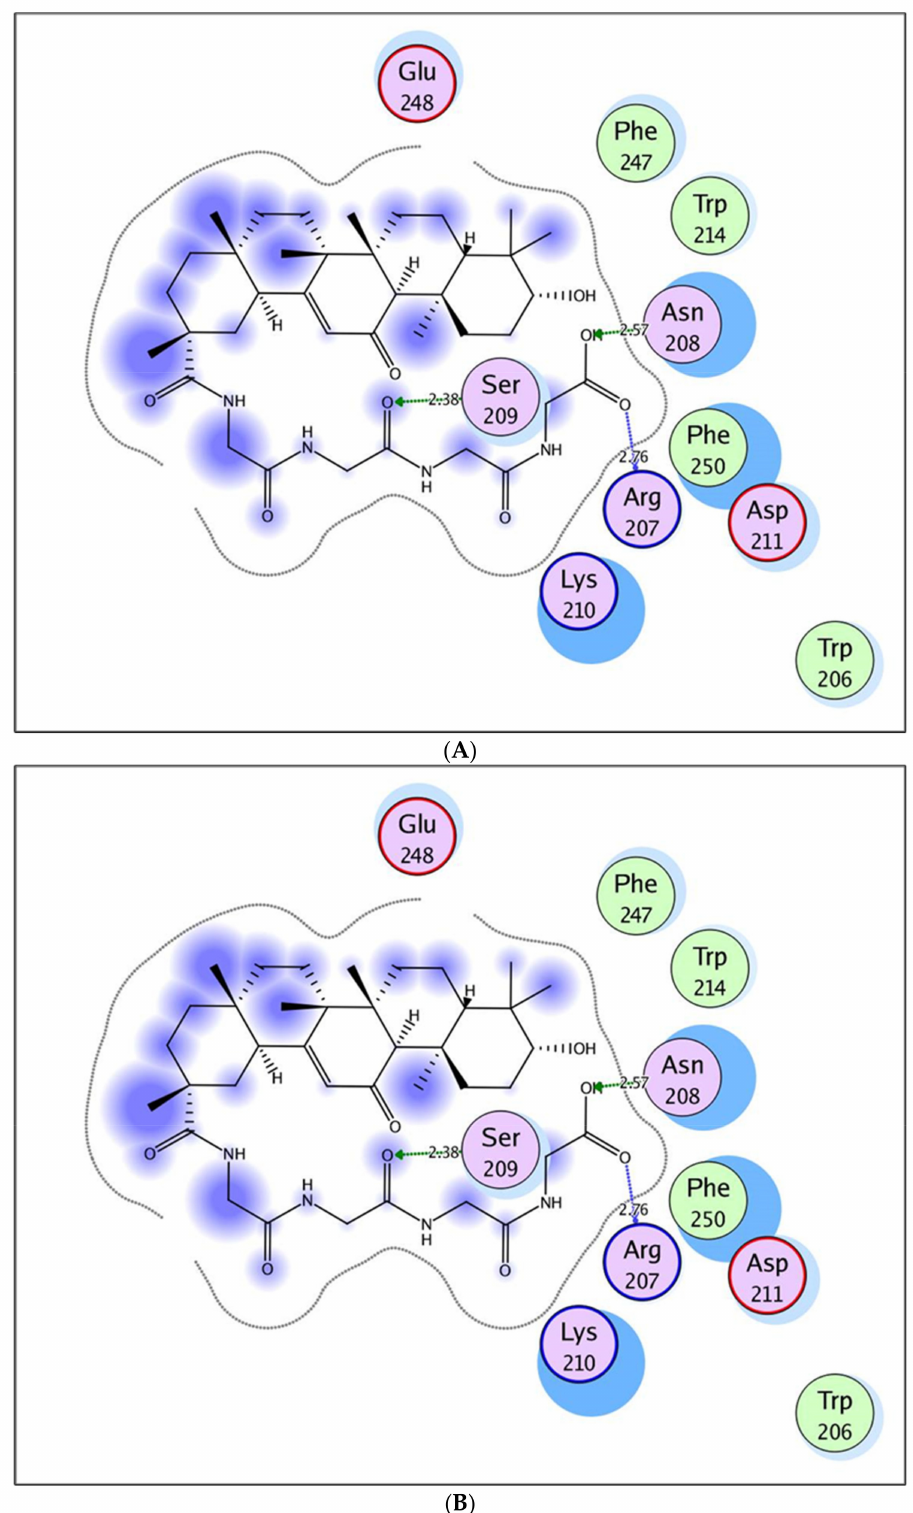
Figure 6. Maps ( A ) and ( B ) explore 2D and 3D binding modes of the promising target 5 within the active site of caspase-3 (PDB: